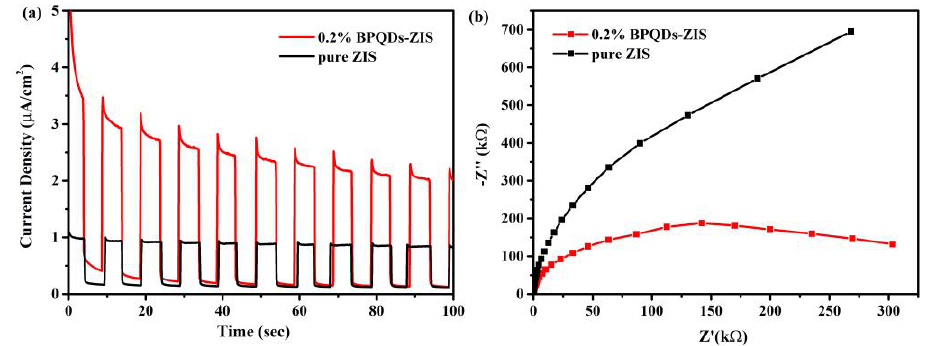
Figure 9. Transient photocurrent response ( a ) and electrochemical impedance spectra ( b ) of pure ZnIn 2 S 4 and 0.2% BPQD–ZIS hybrids. ZnIn 2 S 4 and 0.2% BPQD–ZIS